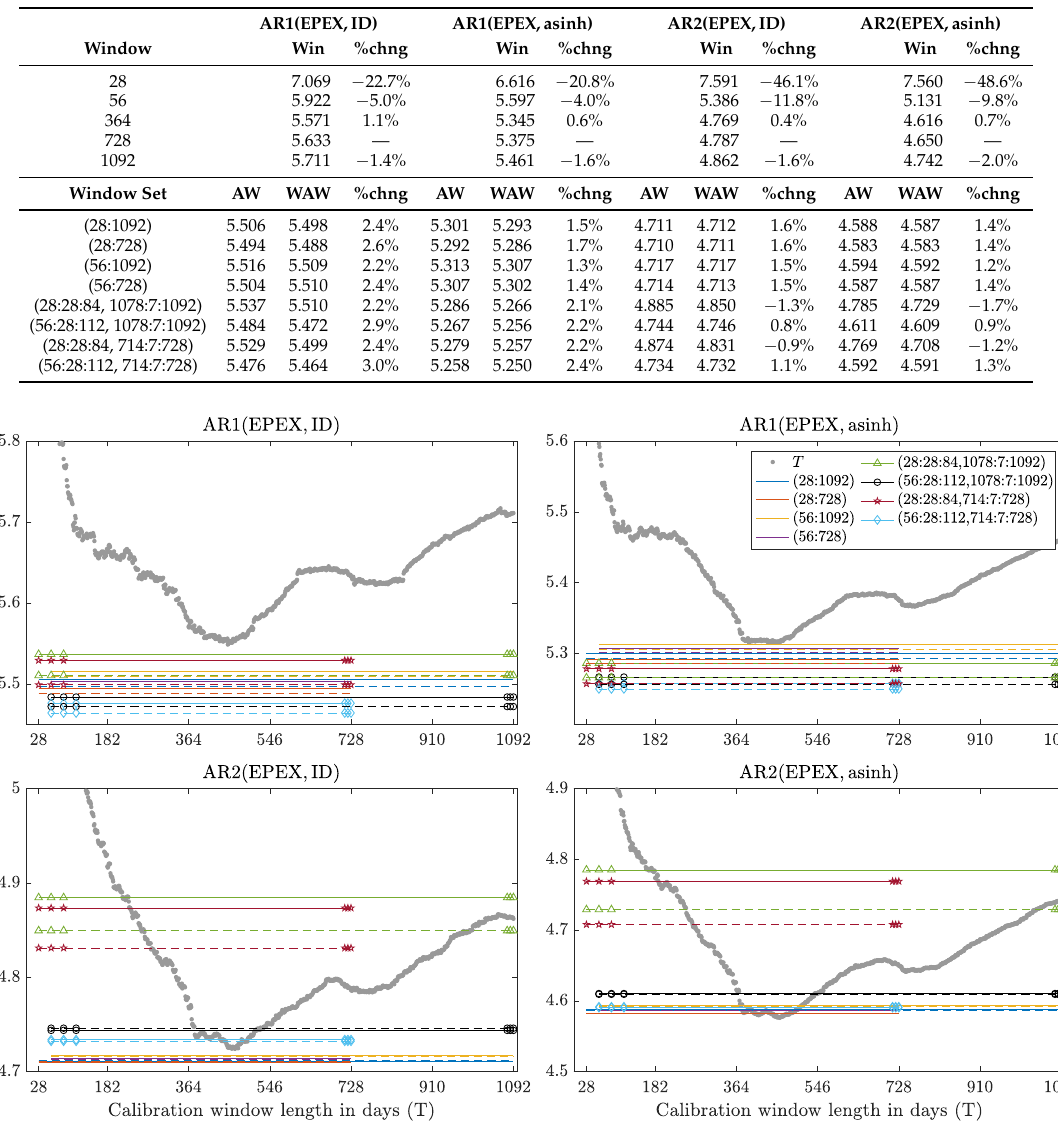
Table 4. Mean absolute errors (MAE) of the AR1 and AR2 models fitted to ID - or asinh -transformed EPEX data for selected windows ( T ) and window sets ( T ). Relative improvements (%chng) of the Win ( T ) and WAW ( T ) forecasts with respect to Win (728) are also reported.